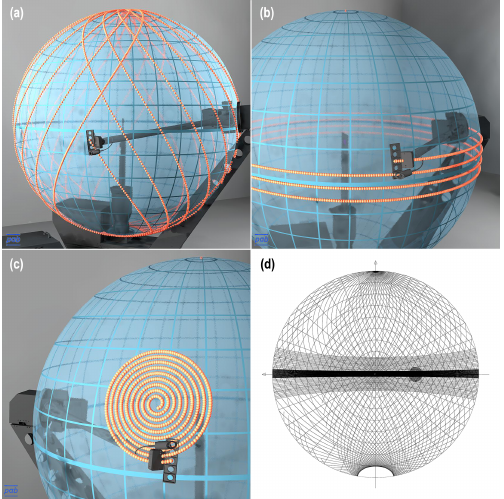
Figure 5. The goniophotometer’s scan paths: A continuous movement of the detector describes a sphere around the sampling aperture and captures all scattering directions ( a ); It is refined by a set of densely offset orbits parallel to the orientation of the slats, covering up- and downward deflected light ( b ); To resolve directly transmitted light, the detector moves on a spiral pattern around the expected peak direction ( c ); Measurements resulting from paths a-c are combined as illustrated by the projection of the effective set of detector positions on the transmission hemisphere for one incident direction ( d ). (Image courtesy ( a – c ): pab advanced technolgies